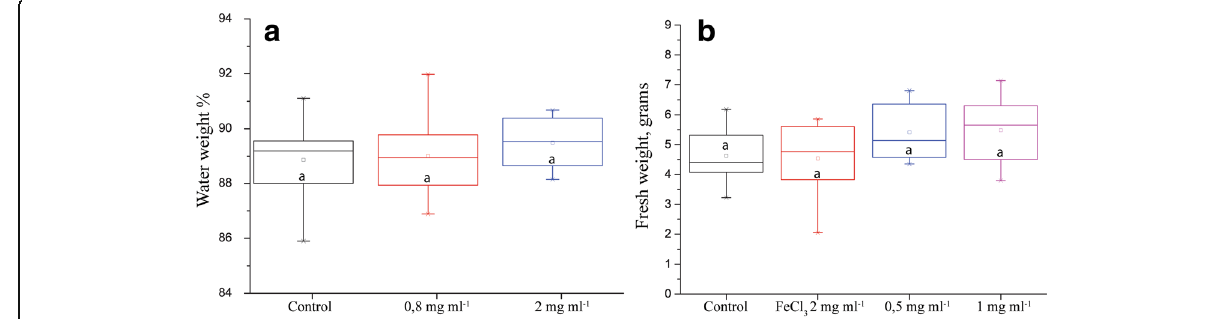
Fig. 2 Plant parameters after drought stress. a Percent of plant weight that constitutes water. b Plant biomass after 5 days of drought ( n = 8, p value = 0.127). Different letters signify statistically significant